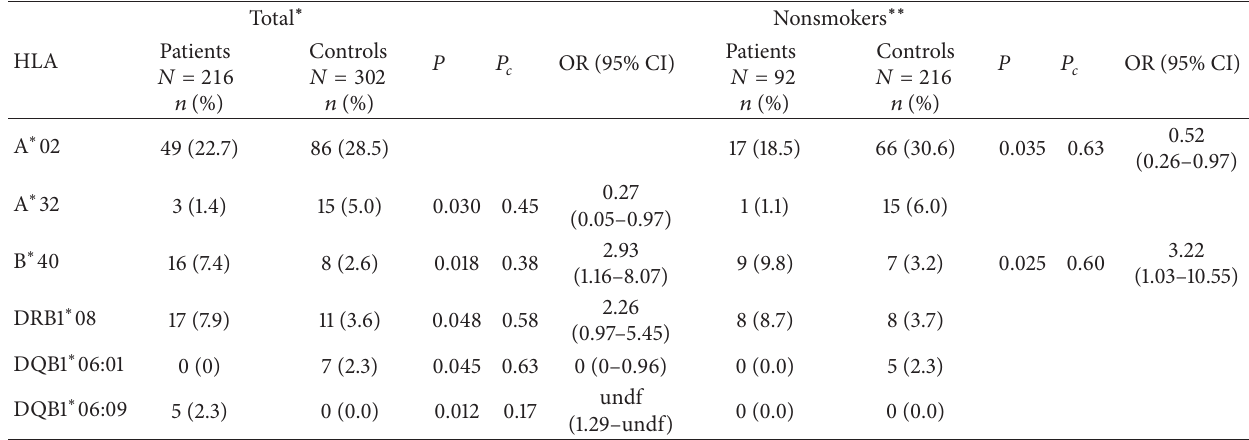
Table 2: HLA associations between chronic periodontitis patients and